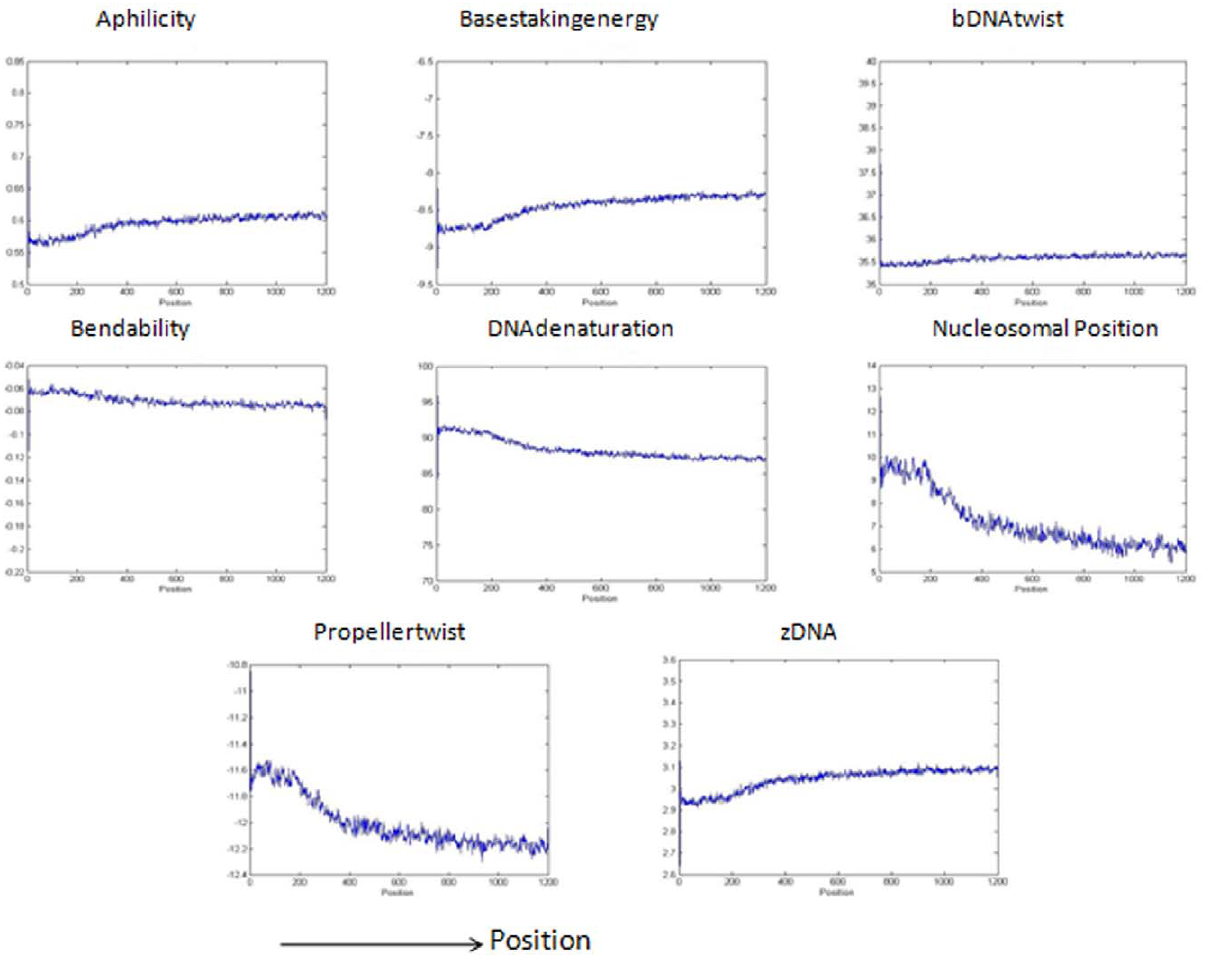
Figure 4. Structural pattern of eight different features for the nonpromoter sequences taken from EMBL and EID database. The sequences used here are predicted as true promoters by grammars. The structural profiles are plotted with average value of window size 3 nt.